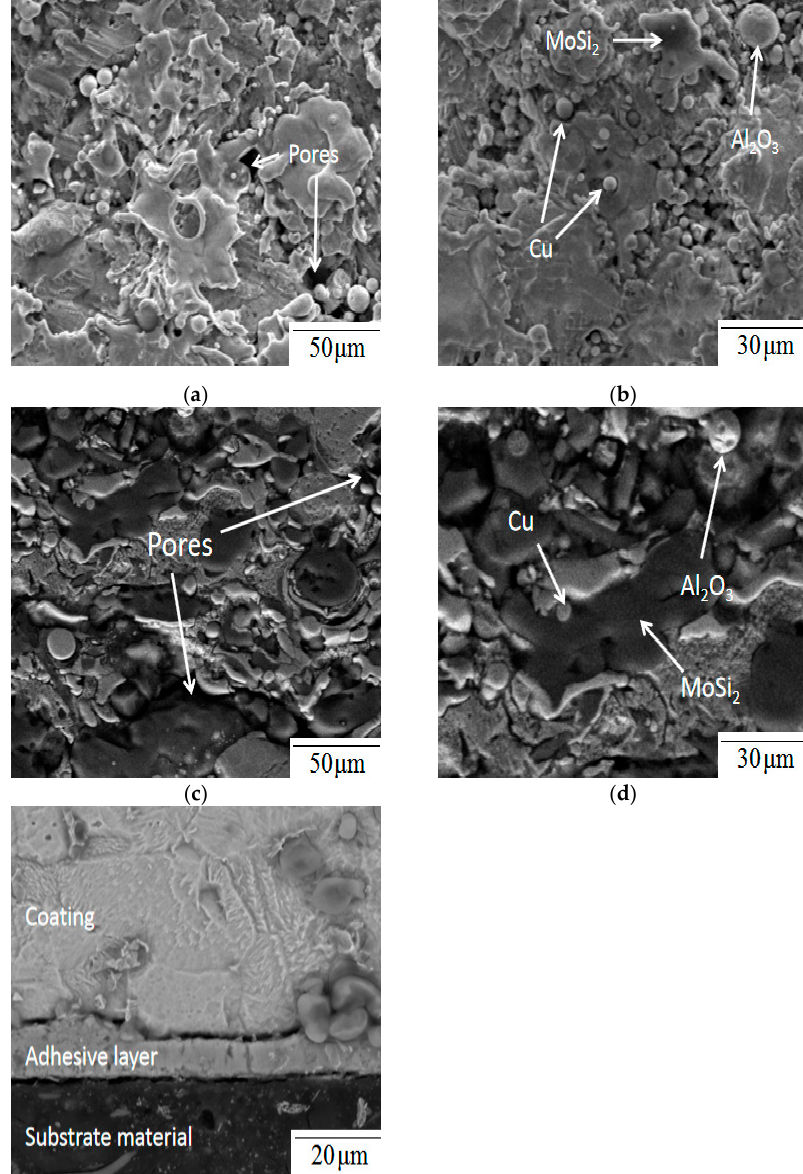
Figure 2. SEM micrographs of the Al 2 O 3 -MoSi 2 -Cu coating: ( a ) some pores exist in Al 2 O 3 -MoSi 2 -Cu coating surface; ( b ) distribution of different particles on coating’s surface; ( c ) fracture surface SEM micrograph of the Al 2 O 3 -MoSi 2 -Cu coating; ( d ) distribution of different particles in the coating’s fracture surface; ( e ) fracture surface SEM micrograph of substrate material and